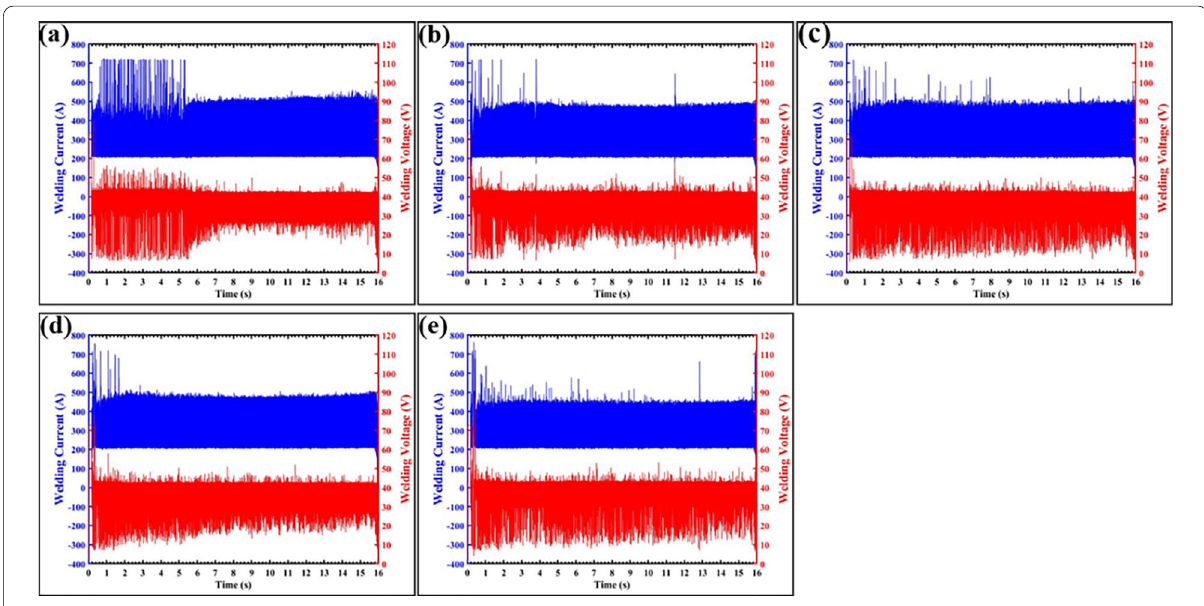
Figure 10 Current and voltage waveforms under shielding of ( a ) Ar